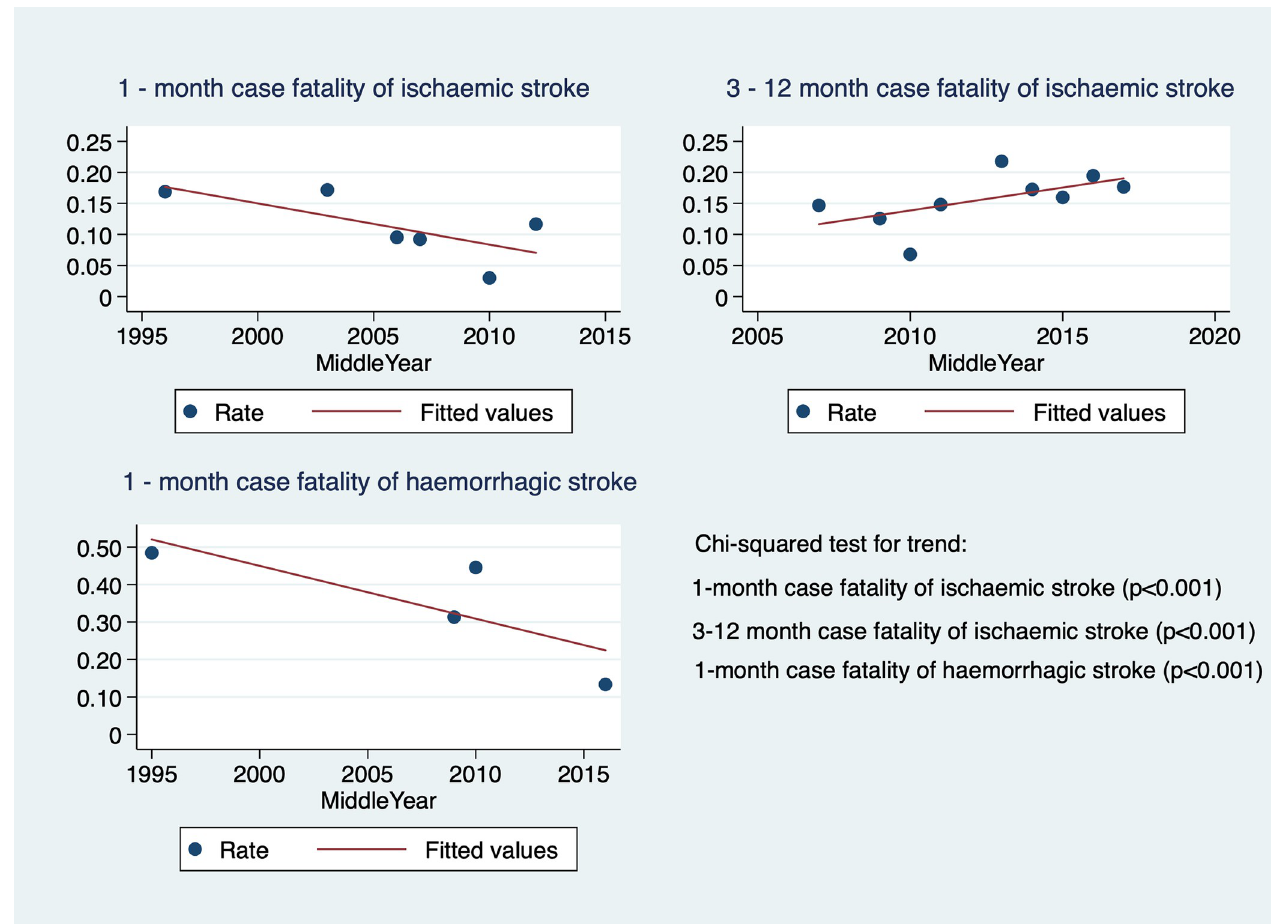
Fig 6. Scatter plots of stroke case-fatality by median study